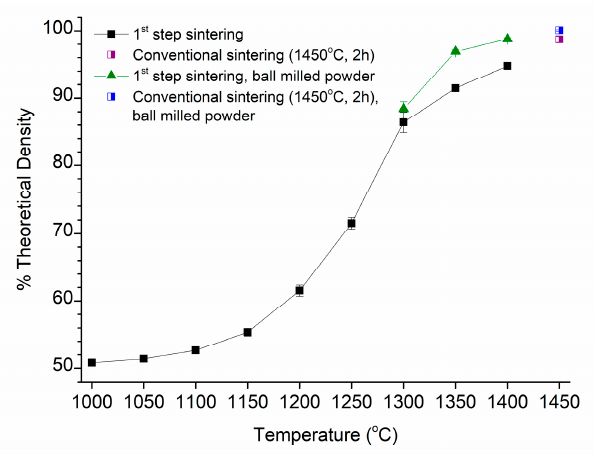
Figure 3. Density of samples after first step sintering vs. first step sintering temperature T1.